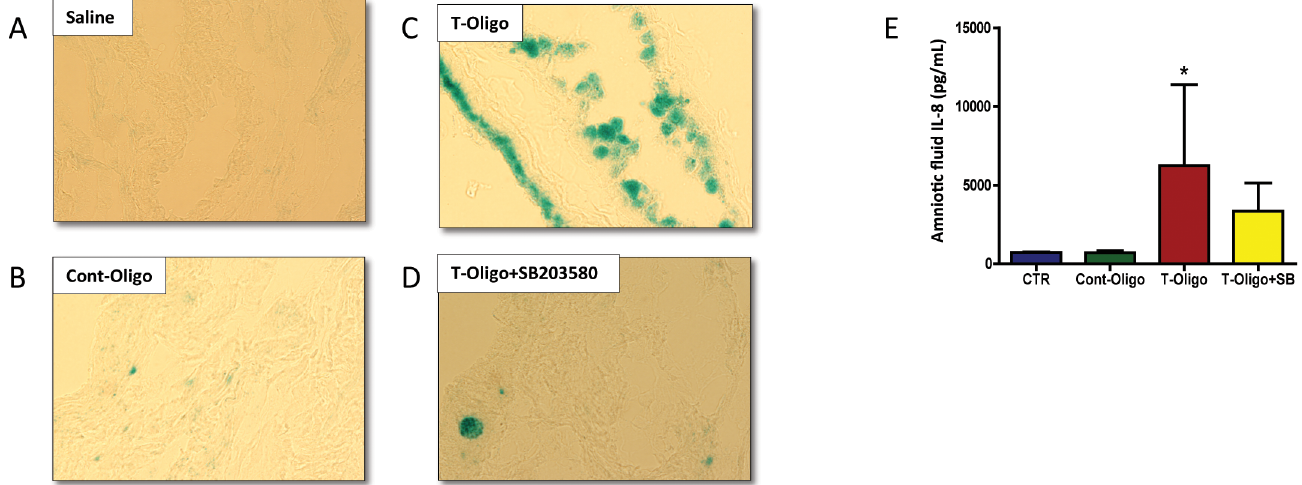
Fig 5. Senescence and inflammation induced by T-oligos in CD-1 pregnant mice. (A-D) Senescence associated β -galactosidase (SA- β -gal) staining of murine amniotic sac. Single blue stained cells indicate β -gal activity. A. saline, B. Cont-oligo, C. T-oligo and D. T-oligo+SB203580 (p38MAPK inhibitor) treated mice. SA- β -gal staining is pronounced in T-oligo treated mice. (E) Concentration of interleukin (IL)-8 protein in murine amniotic fluid. Higher levels of IL-8 were found in T-oligo treated animals compared to controls (saline and Cont-oligo). The production of IL-8 was inhibited by simultaneous treatment with SB203580. ( * ANOVA, p < 0.05). Results are representative from 3 animals/ group. (Telomere mimetic overhang sequence (T-oligo, [TTAGGG] 2 ); control oligonucleotides (Cont-oligo, [AATCCC] 2